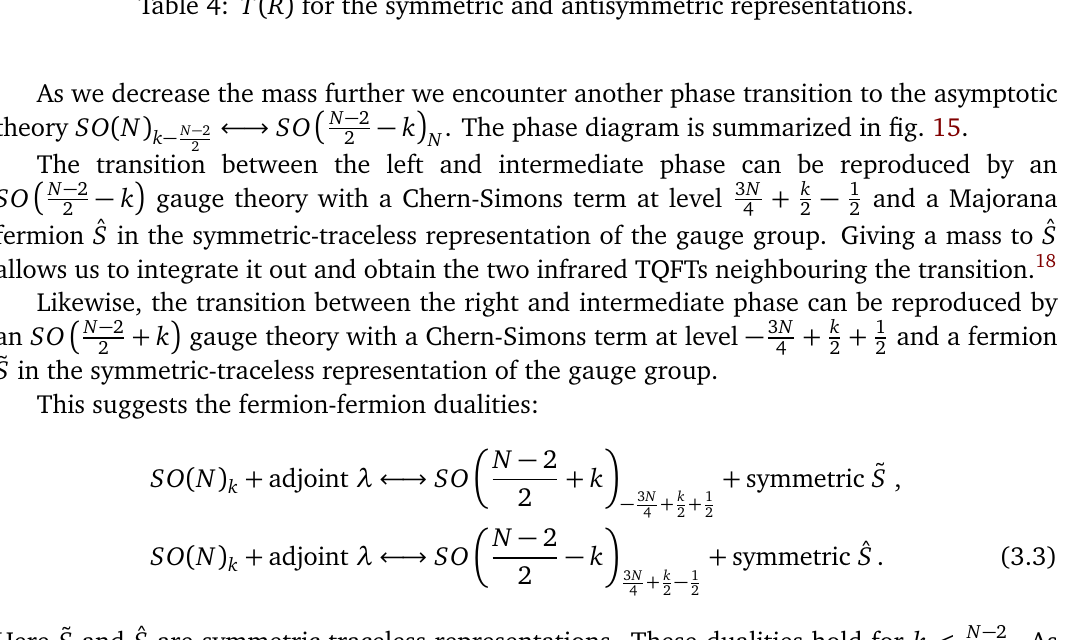
Table 4: T ( R ) for the symmetric and antisymmetric